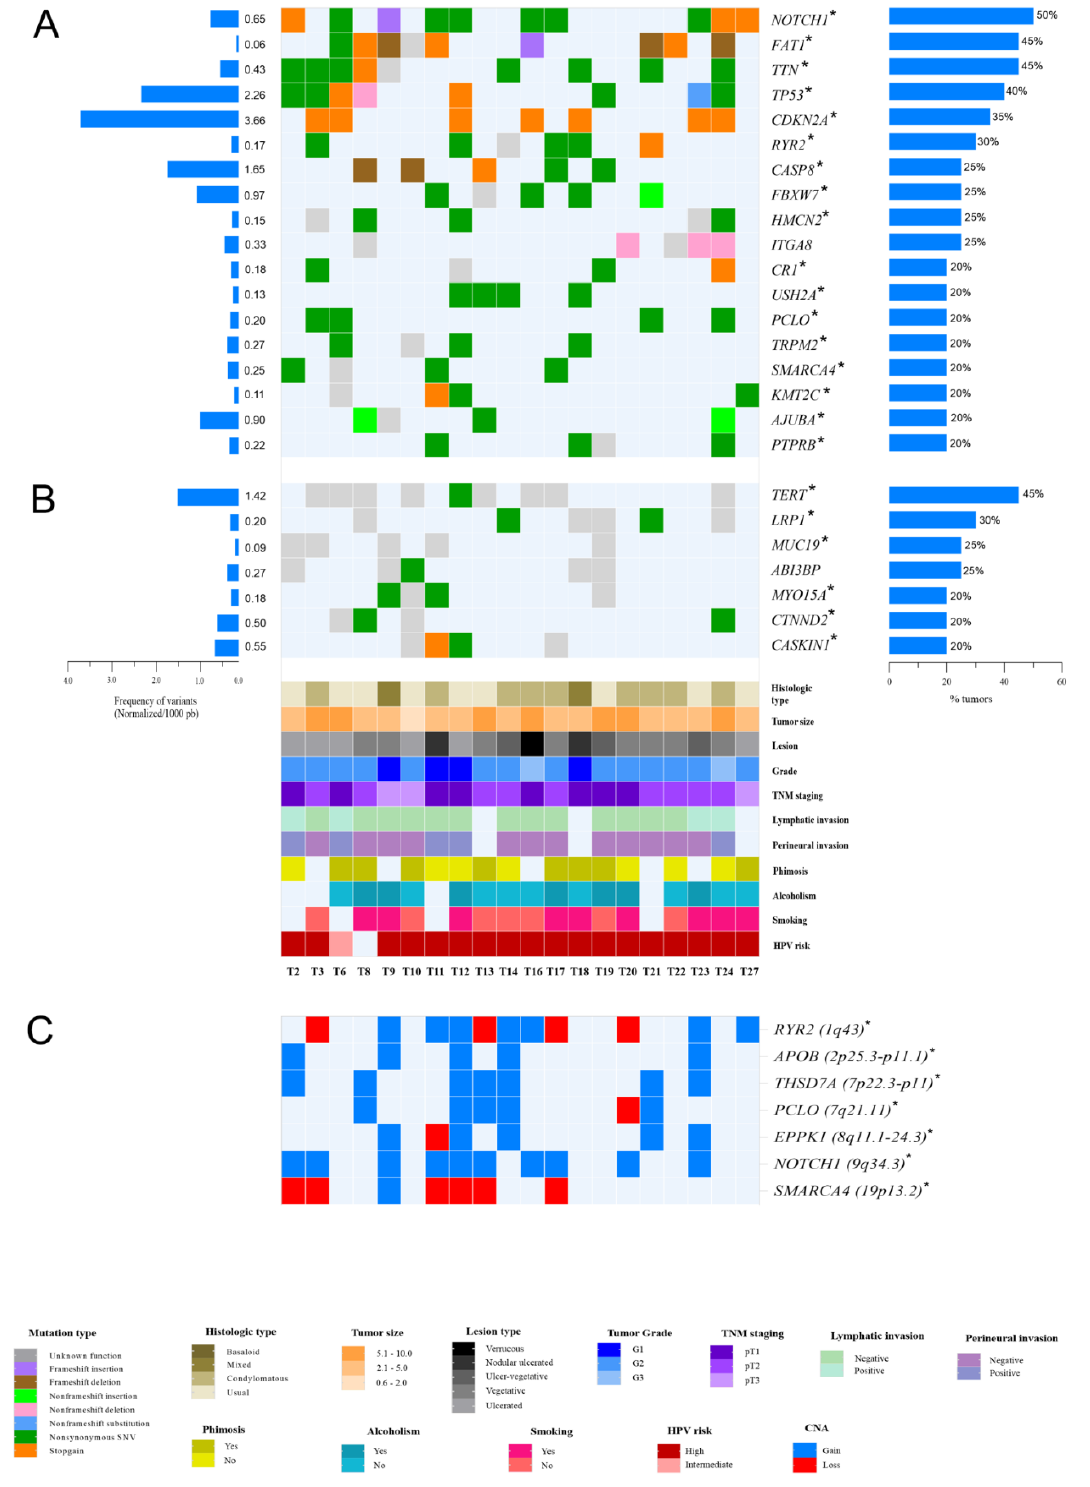
Figure 2. Top genes and variants identified in at least 20% of human papillomavirus-associated penile squamous cell carcinomas according to clinical and histopathological variables. The charts in ( A ) (exonic region), ( B ) (intronic region), and ( C ) (CNV-seq) present the mutational profile of the 20 paired tumors. The matrix at the bottom of (B) shows the clinical–histopathological profile and the HPV status of each case (identified by the samples ID). Horizontal bar plot on the right shows the frequency of each altered gene in the 20 paired tumors, and on the left is the number of variants normalized according to the gene size (1000 bp). * Genes with variants localized at HPV integration sites; CNV-seq, copy number variation by sequencing; CNA, copy number